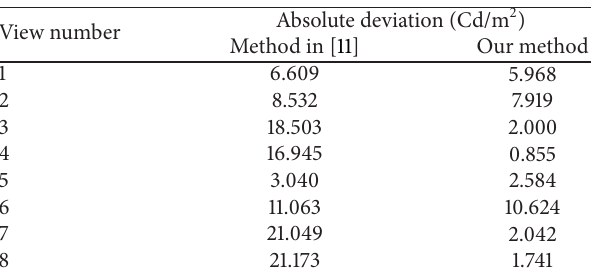
Table 2: Crosstalk reduction results (absolute deviation) compari-